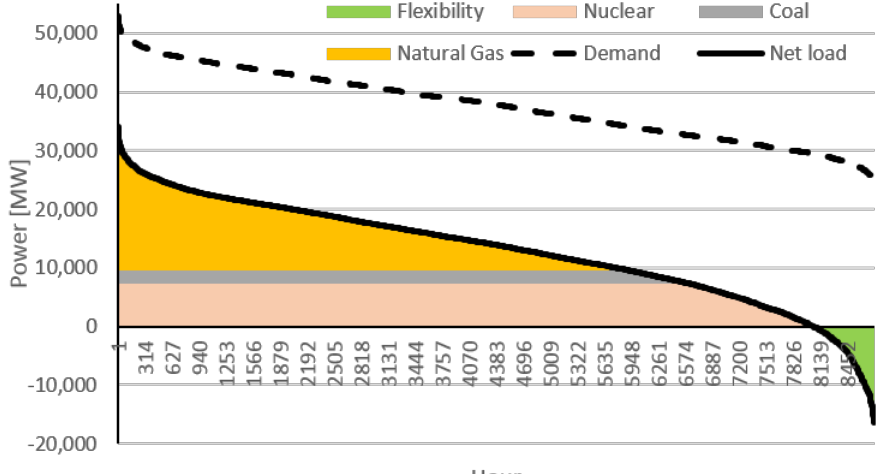
Figure 5. Iberian nRESL monotone curve and thermal technologies power division in Figure 5 : Iberian nRESL monotone curve and thermal technologies power division in 2030.